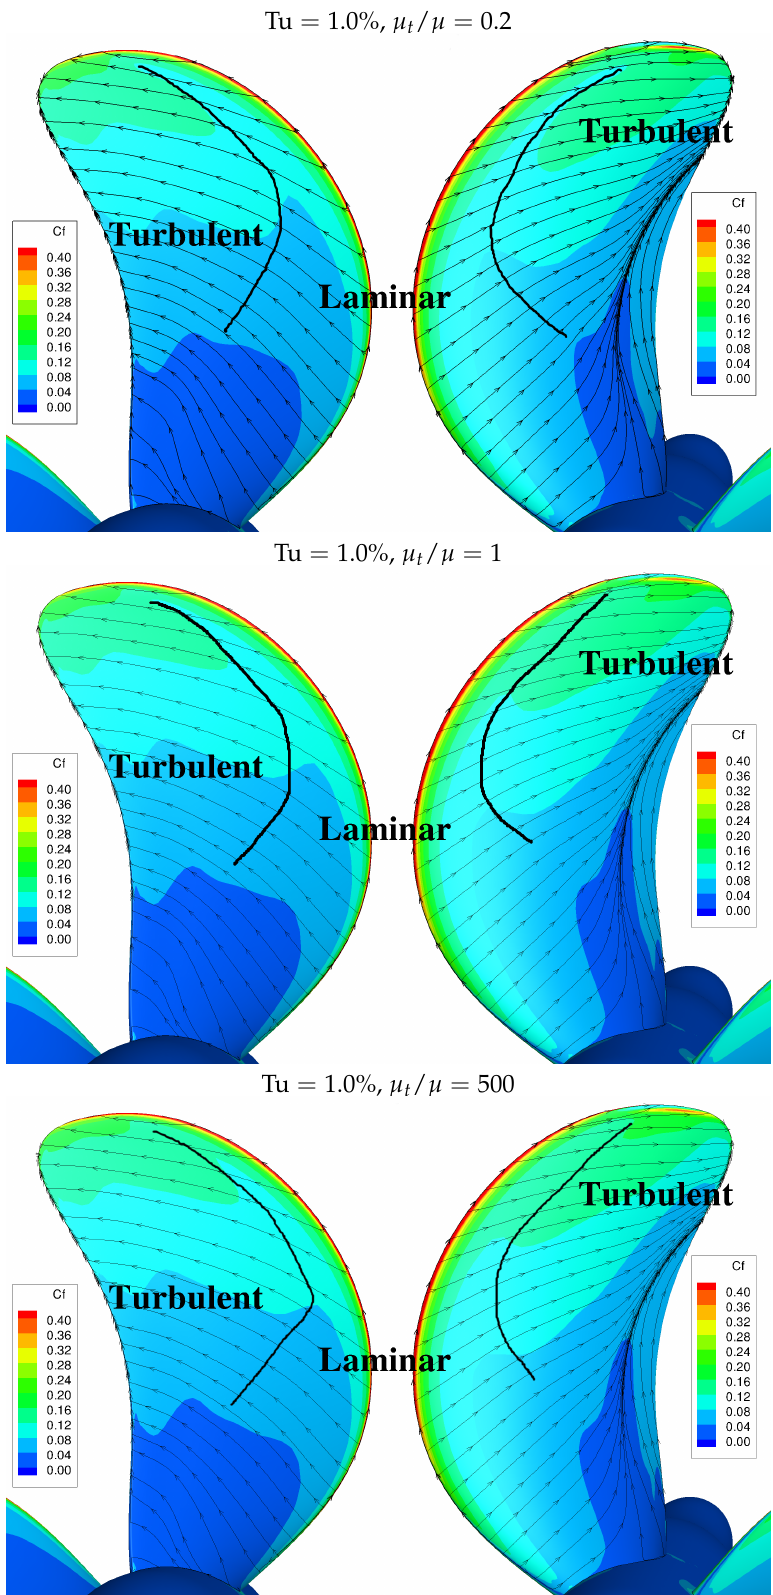
Figure 6. Influence of the inlet turbulence quantities on the propeller blade flow. Limiting streamlines and skin friction coefficient using the k − ω SST turbulence model at Re = 1 × 10 5 for J = 0.568. Pressure side ( left ) and suction side ( right